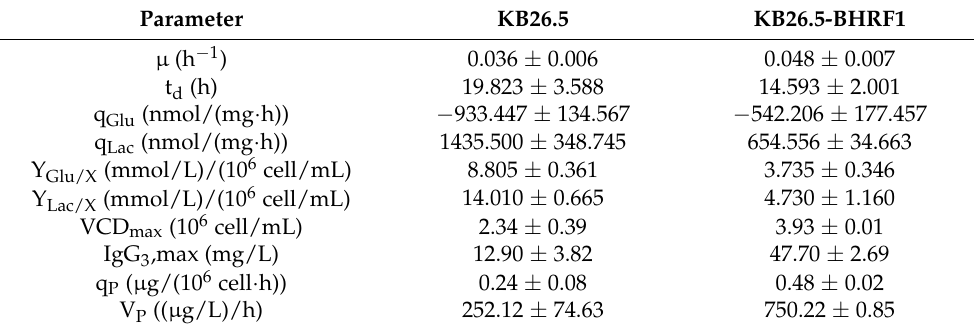
Table 3. Main physiological parameters determined for KB26.5 and KB26.5-BHRF1 cultures in 2 L bioreactors. Values were calculated as the means of data obtained from duplicate